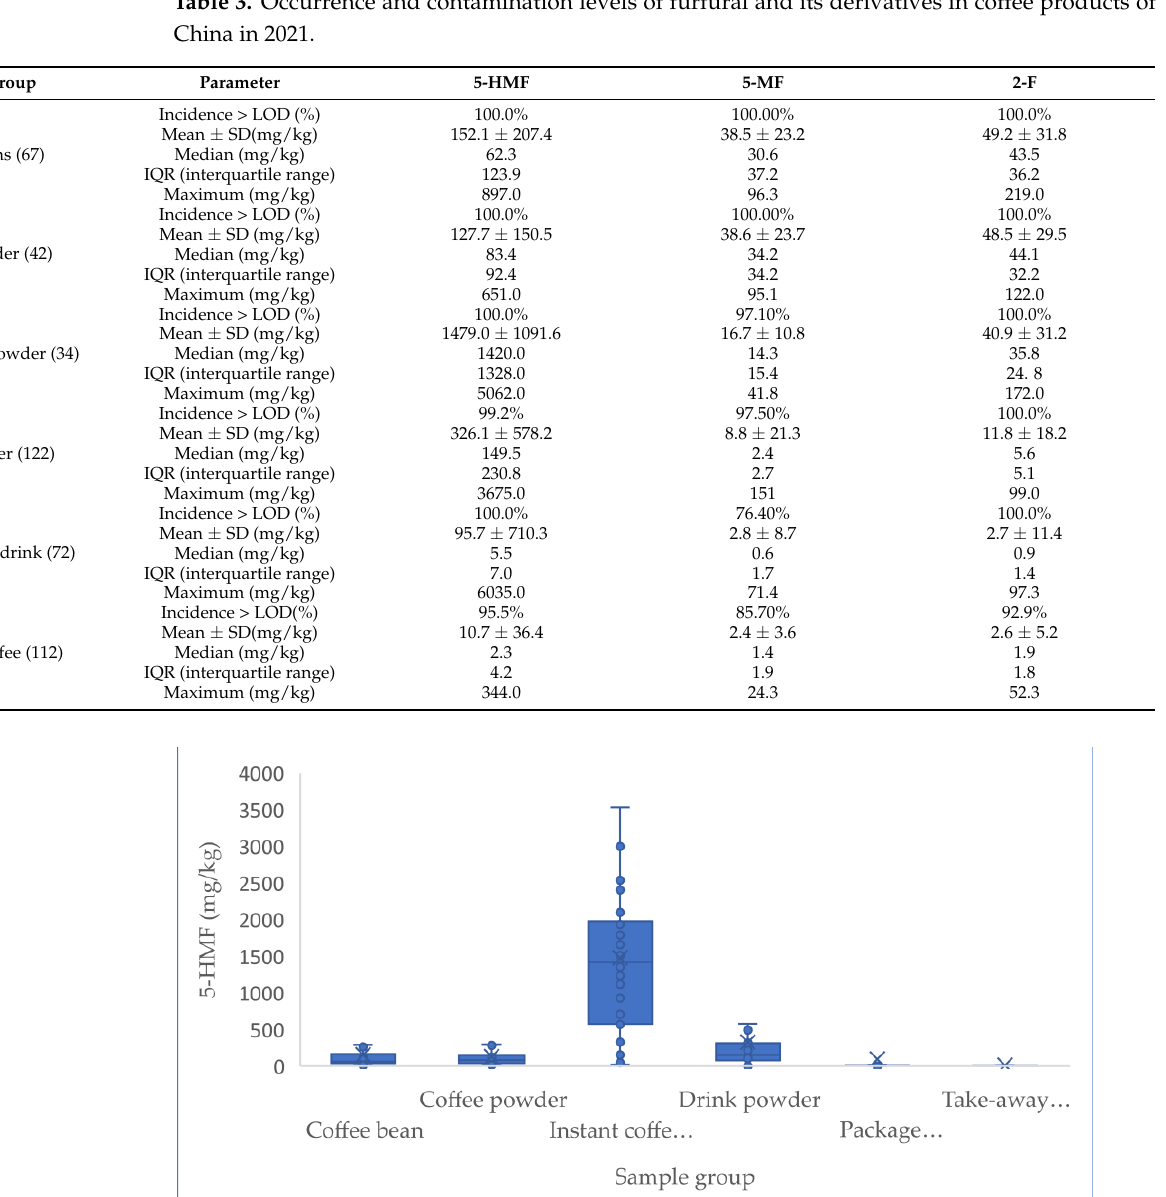
Figure 2. Box plots comparing 5-MF and 2-F concentrations in 6 coffee products in 2021. Lower and upper ends of the box represent the lower and upper quartiles (25th and 75th percentiles), the mid- dle line represents the median, and the whiskers represent the minimum and maximum, excluding outliers.